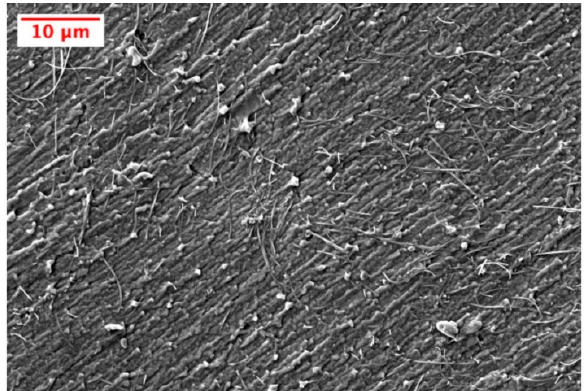
Figure 4. Representative SEM image of the quality of MWCNT dispersion in the polydimethylsiloxane (PDMS) matrix for a 2.5 wt. % sample.